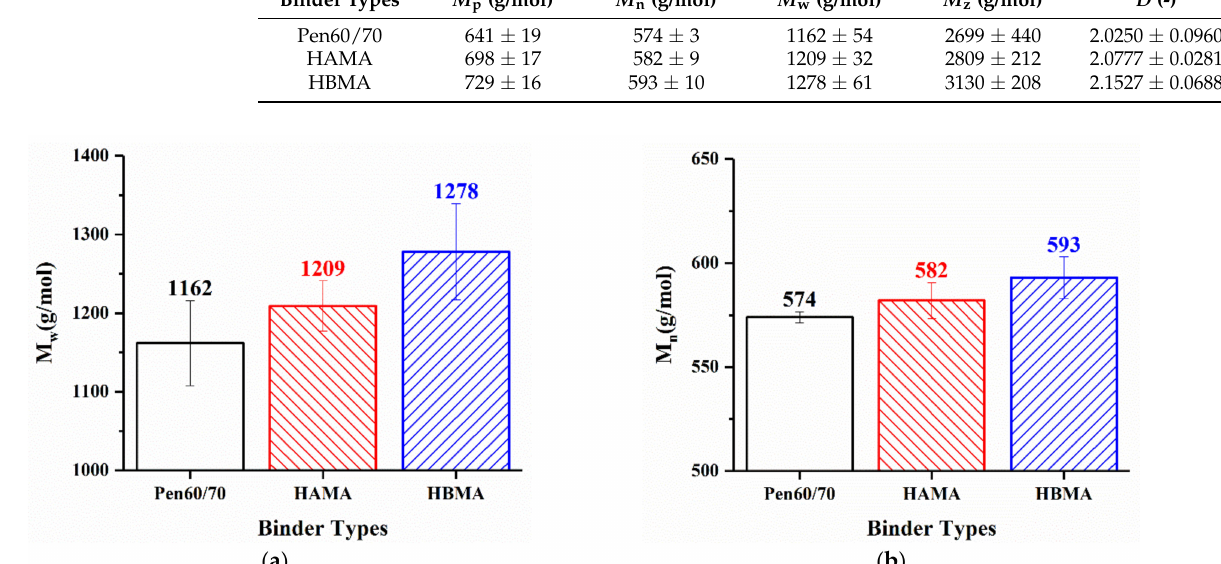
Figure 11. GPC result analysis: ( a ) weight-average molecular weight and ( b ) number-average molecular